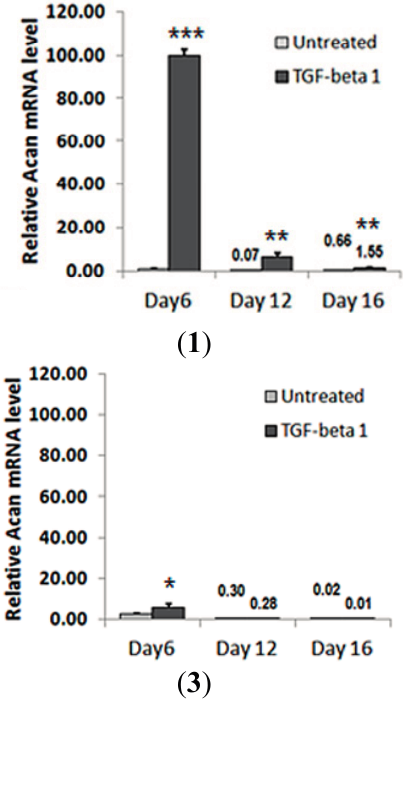
Figure 5. Effects of TGF- β 1 on the chondrogenic differentiation of ATDC5 cells expressing WT, MED or SEMD MATN3 during a 16 day time course. ATDC5 cells were seeded into 12 well culture plates and the growth media replaced with DMEM:F12 supplemented with or without TGF- Β 1 (10 ng/mL). On Days 6, 12 and 16, gene expression was quantified in each group: untransfected ATDC5; WT MATN3 ; MED; SEMD, respectively. ( A ( 1 – 4 )) expression of Acan ; ( B ( 1 – 4 )) Col2a1 and ( C ( 1 – 4 )) Col10a1 was measured using real-time RT-PCR. Relative quantities less than 1.00 are so indicated for clarity. * p ≤ 0.05, ** p ≤ 0.01 , *** p ≤ 0.005 vs. TGF- β 1 untreated